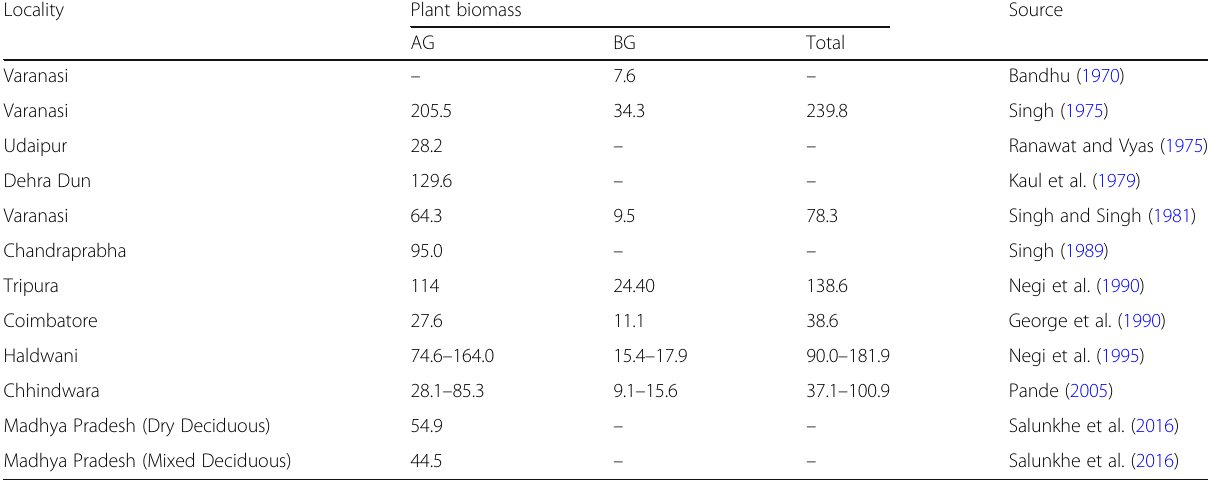
Table 5 Allocation of plant biomass (t ha − 1 ) in different components of tropical dry forest of India Locality